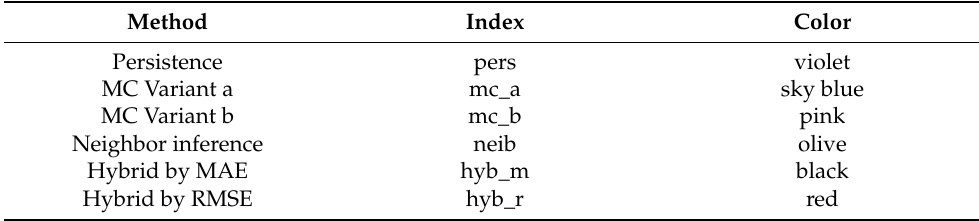
Table 3. Overview of prediction methods with their indices and color codes.